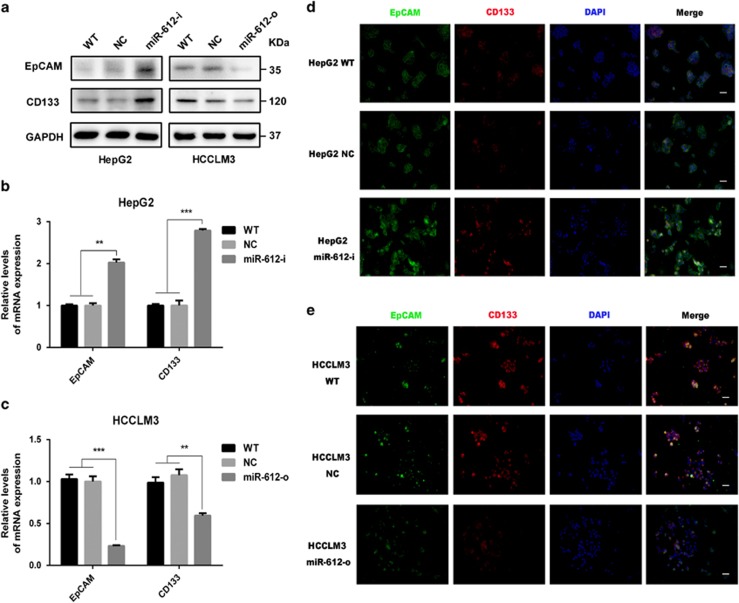
The inverse correlation between miR-612 and EpCAM, CD133. (a) Western blot analysis. (b) qRT-PCR. (c) Immunofluorescence staining to evaluate the expression levels of EpCAM, CD133 in transfected with miR-612 mimics, inhibitor and negative control in HCCLM3 and HepG2 cells. Scale bar: 50 μm. Statistical analysis by Student's t-test (**P<0.01, ***P<0.001)